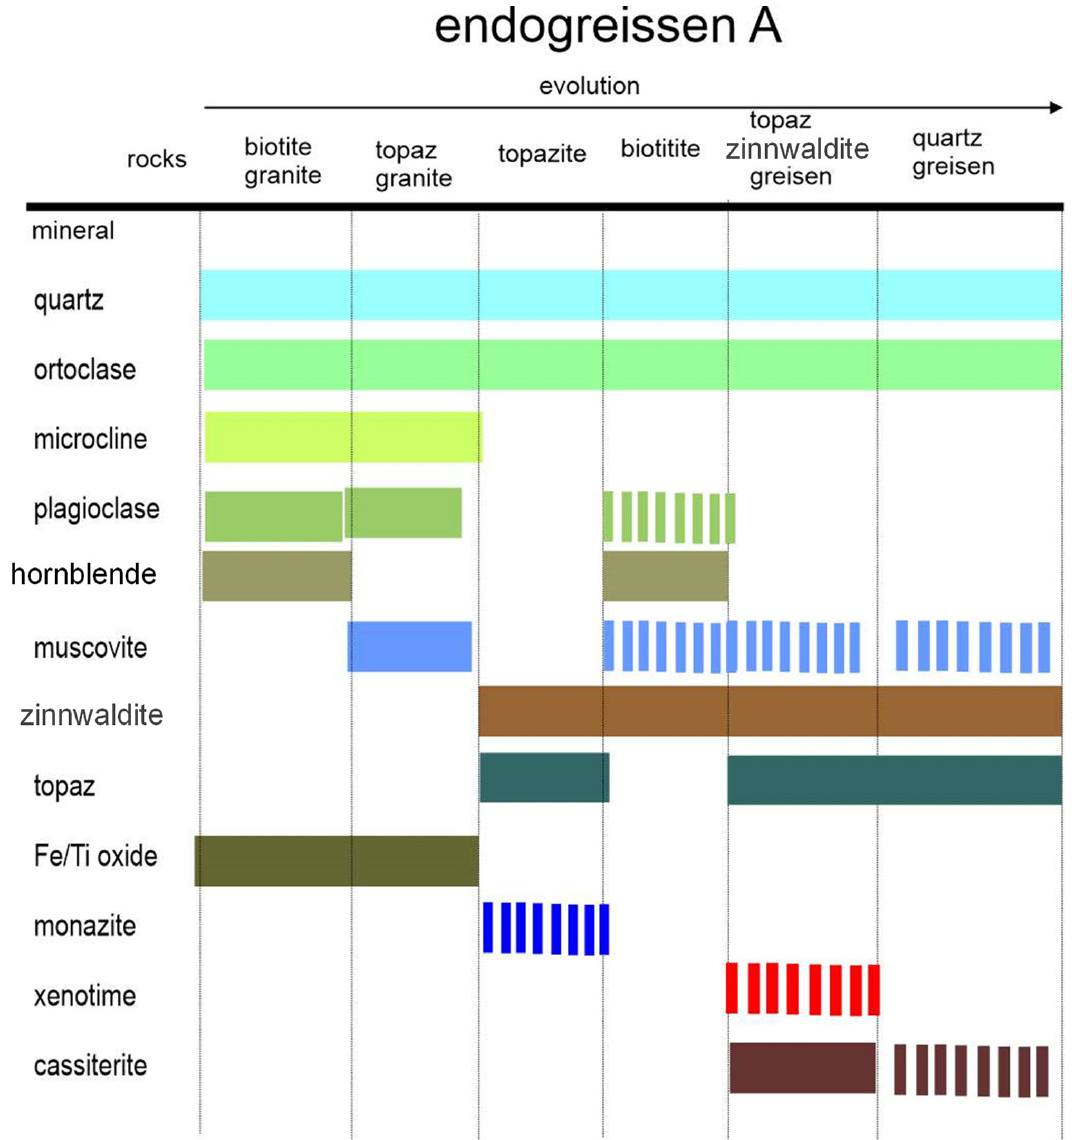
Figure 10. Mineral paragenesis was obtained by petrographic analysis of samples related to endogreisen A. The biotite-granite initial magma passes to topaz-granite ending in greisen (and topazite), ending in zinnwaldite-topaz greisen and quartz-greisen. (B) Endogreisen B